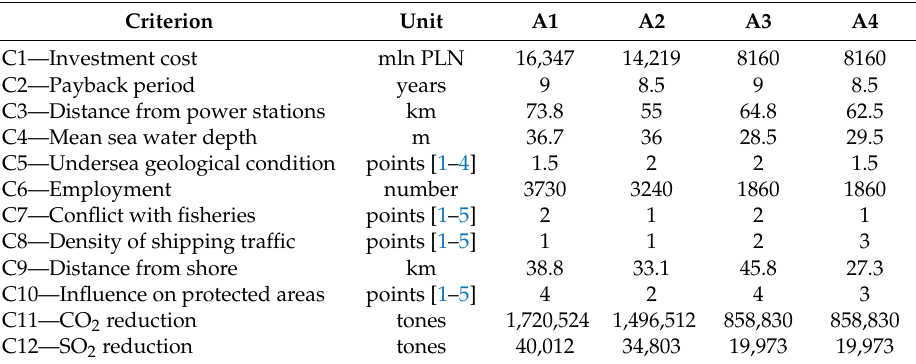
Table 5. Values of the variants with respect to individual criteria.